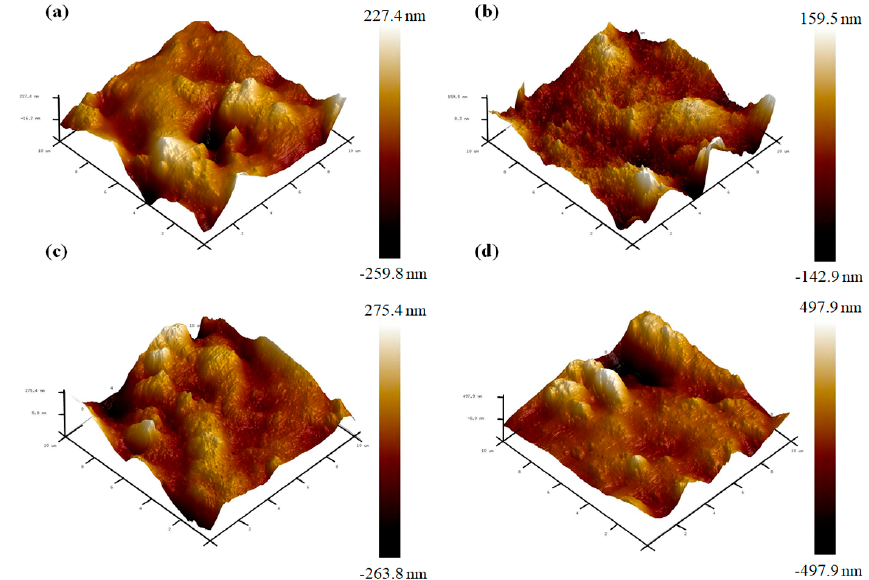
Figure 7. AFM images of the CJP films containing different concentrations of RPE: ( a ) CJP film; ( b ) CJP/0.25% RPE film; ( c ) CJP/0.5% RPE film; ( d ) CJP/1.0% RPE film.